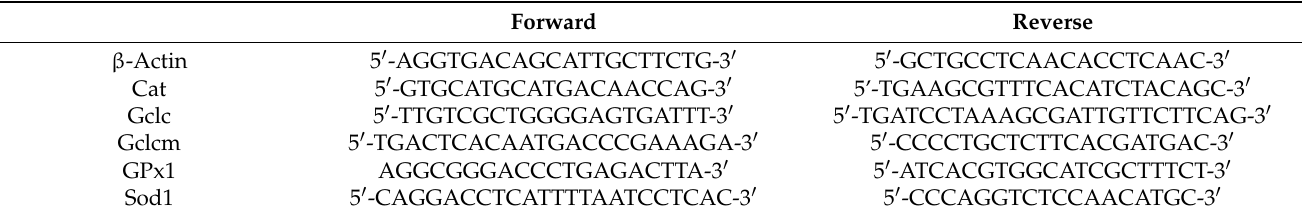
Table 3. Quantitative real-time PCR